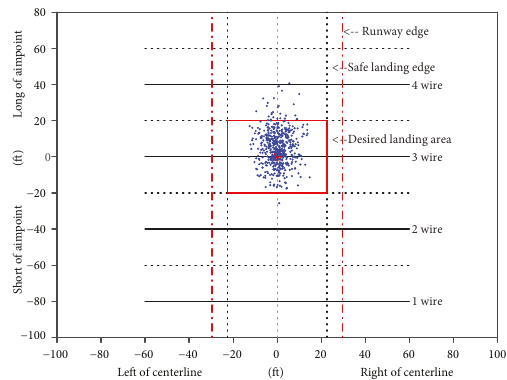
Figure 9: Landing dispersion under NDI controller with L adaptive control augmentation.